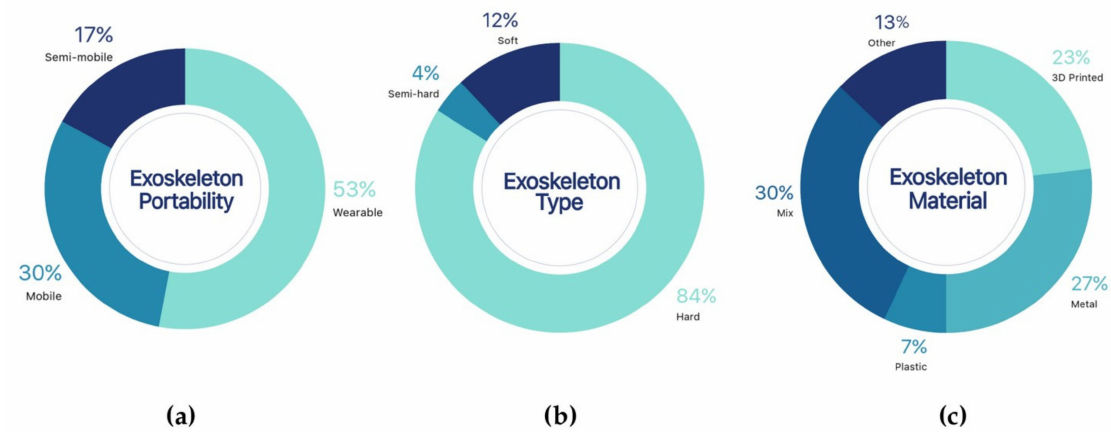
Figure 5. The general distribution of physical properties of the robotic exoskeletons in terms of ( a ) portability, ( b ) exoskeleton type, and ( c ) structural material if